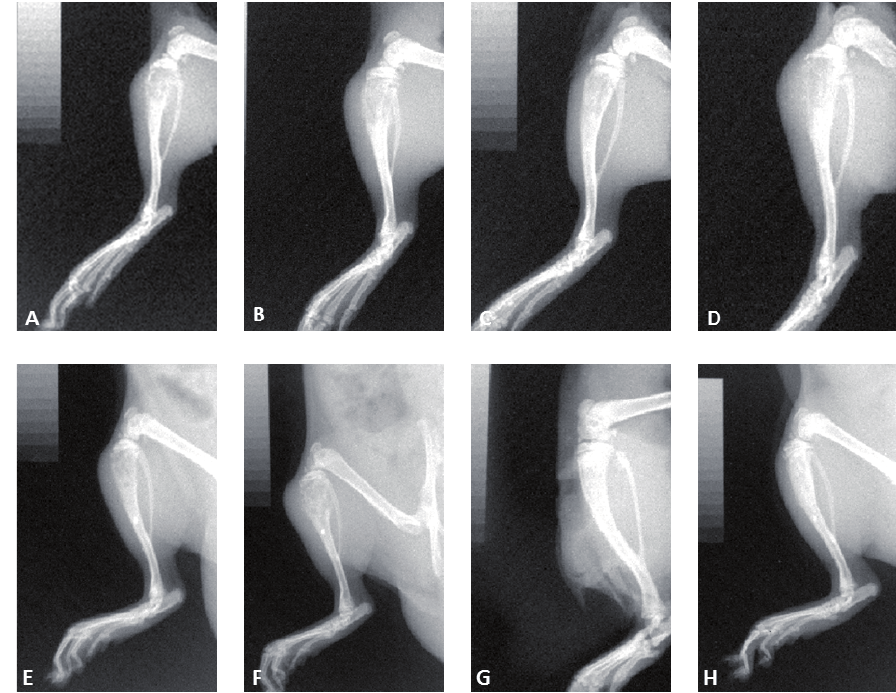
Supplementary figure S1. Representative images of animals demonstrating osteolysis ( A – F ) and lack of osteolysis ( G , H ).